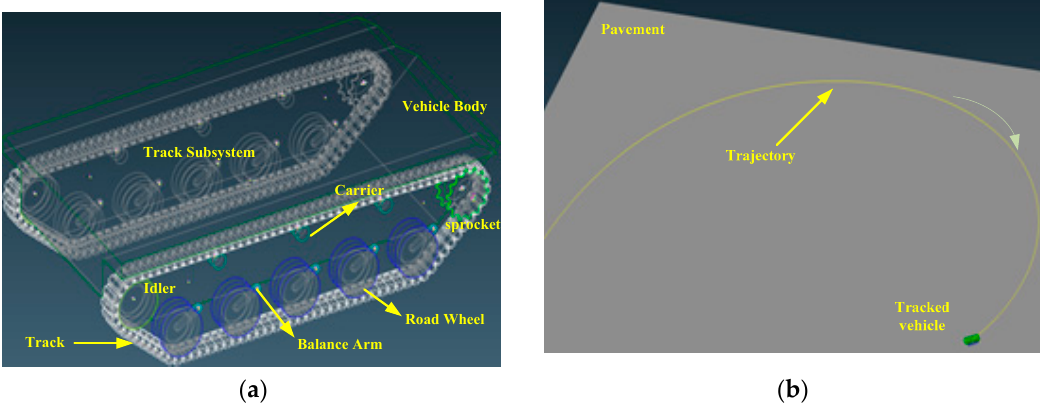
Figure 6. ( a ) Vehicle model in RecurDyn; ( b ) Vehicle model during simulation.